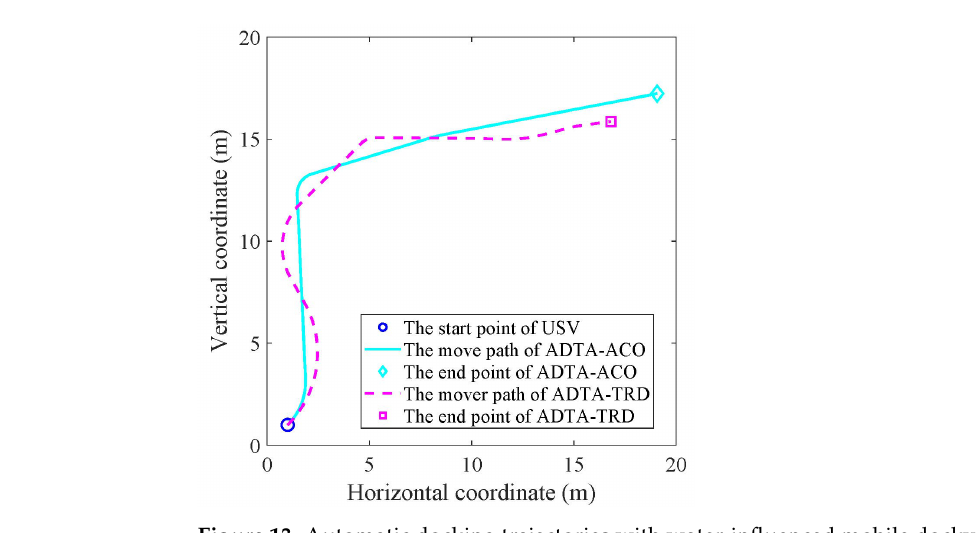
Figure 13. Automatic docking trajectories with water-influenced mobile dockyard. Table 3. The influence of radius influence factor on voyage time.